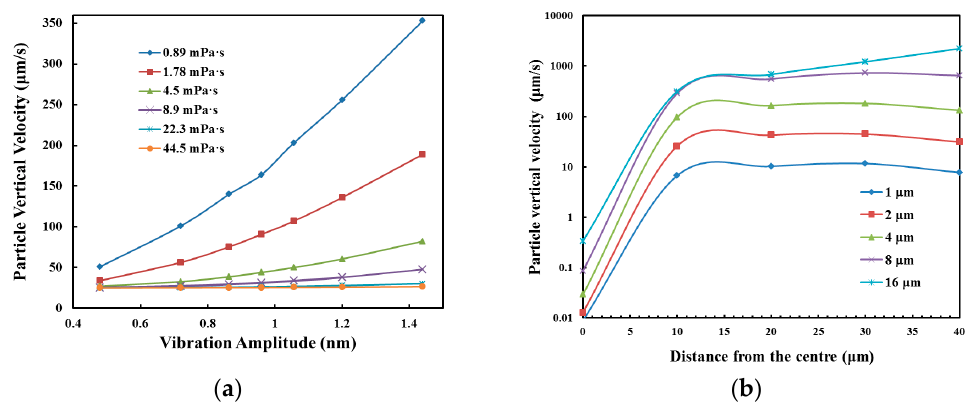
Figure 5. Particle Y-velocity after 10 ms of the SSAW activation under different ( a ) vibration amplitudes and fluid viscosities of 2 μ m particles 20 μ m away from the microchannel center; and ( b ) distances from the center for different particles at the vibration amplitude of 0.94 nm and a viscosity of 0.89 mPa·s.